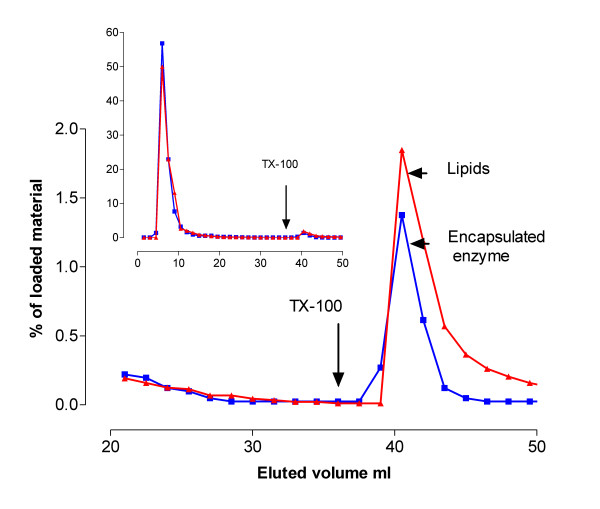
Elution pattern of lipids and encapsulated enzymes following liposome chromatography on G25 column. Liposomes labeled with rhod-PE and containing AChE were chromatographied on G25M. Fractions of 1.5 mL were collected. Fluorescence (in red) and enzyme activity (in blue) were measured as a percentage of the total fluorescence or enzyme activity collected. Arrows indicate the injection of TX-100 on the top of the columns. The general elution profile is represented in the inset.